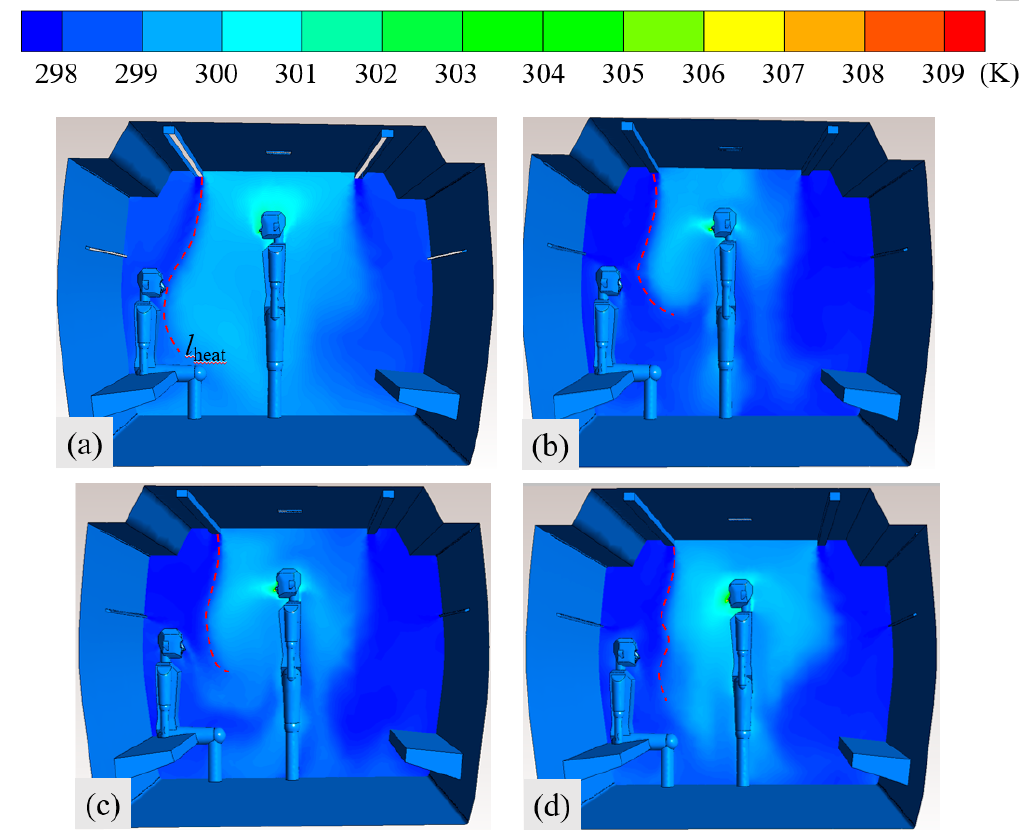
Figure 8. Temperature fields of cars under conventional and SV for Q = ( a ) 8500, ( b ) 8500, ( c ) 7850, and ( d ) 7200 m 3 /h.